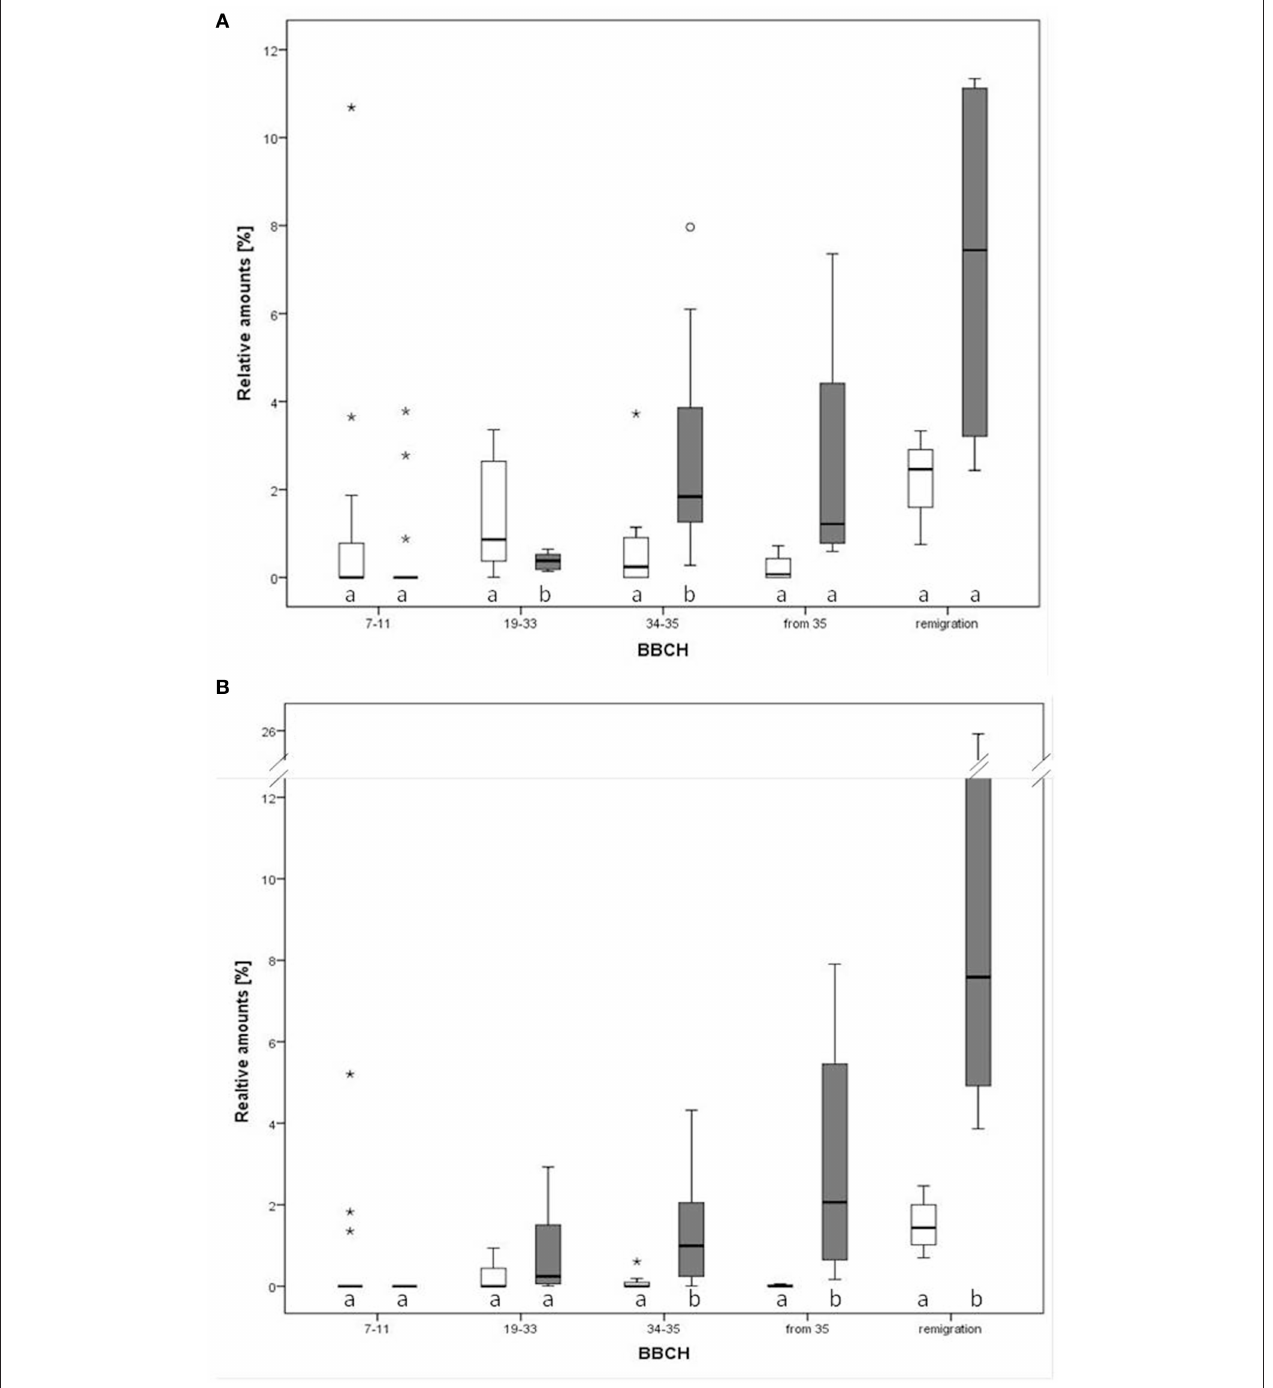
FIGURE 5 | Relative amounts of two compounds in the direct comparison of infected and healthy apple plants ( Malus domestica ) at different phenological growth stages. (A) Ethyl benzoate, (B) methyl salicylate. Different letters denote statistical differences (Mann-Whitney, p < 0.05 ). Notice that outliers are indicated by circles and extremes by